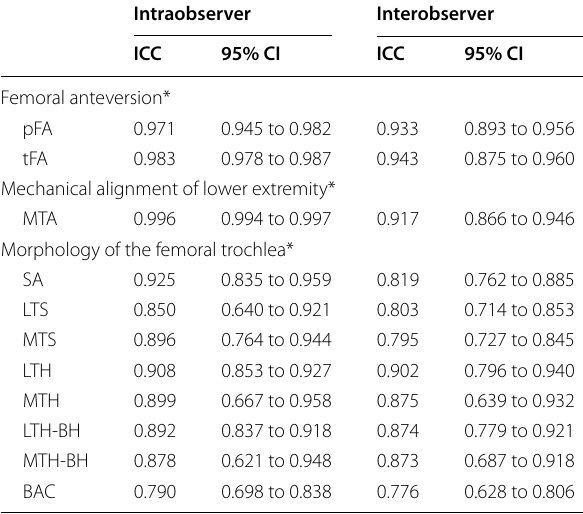
ICC intraclass correlation coefficient, pFA femoral anteversion based on the posterior condylar line, tFA femoral anteversion based on the